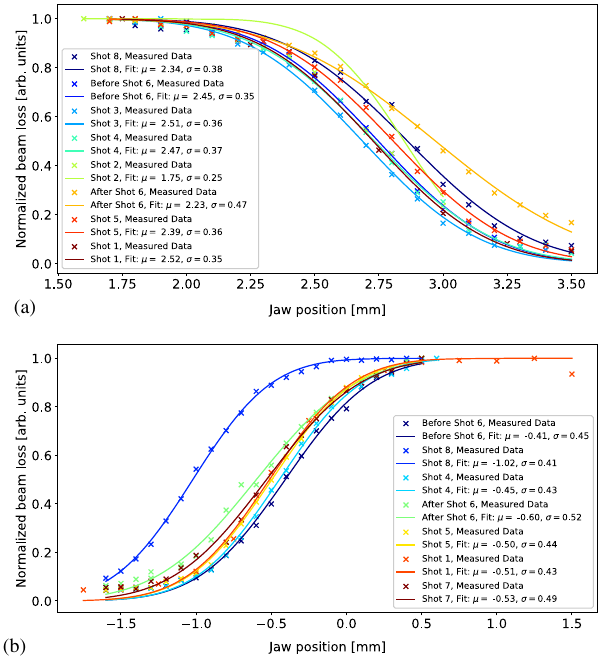
FIG. 17. Gaussian CDF fits to the normalized beam loss as a function of the left and right jaw positions measured during all alignments throughout the test. (a) Left jaw alignments and (b) Right jaw